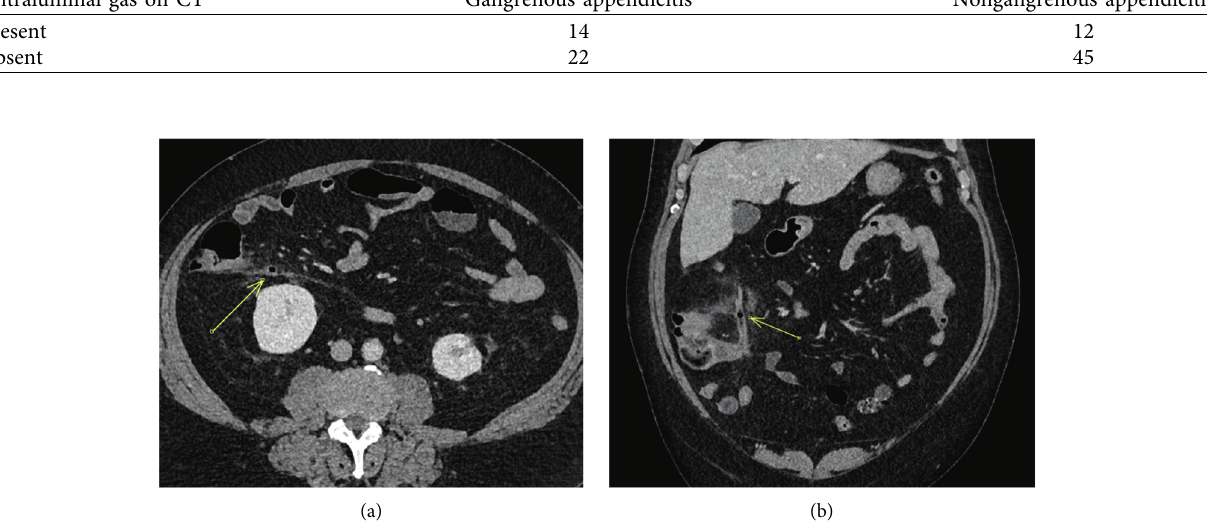
Figure 1: A 64-year-old man with axial (a) and coronal (b) CTabdomen in the portal venous phase showing periappendiceal fat stranding and appendiceal wall hyperenhancement, confirming the clinical suspicion of acute appendicitis. There is a focus of intraluminal gas in the body of the appendix (arrow). Gangrenous appendicitis was confirmed intraoperatively and on subsequent histopathology.